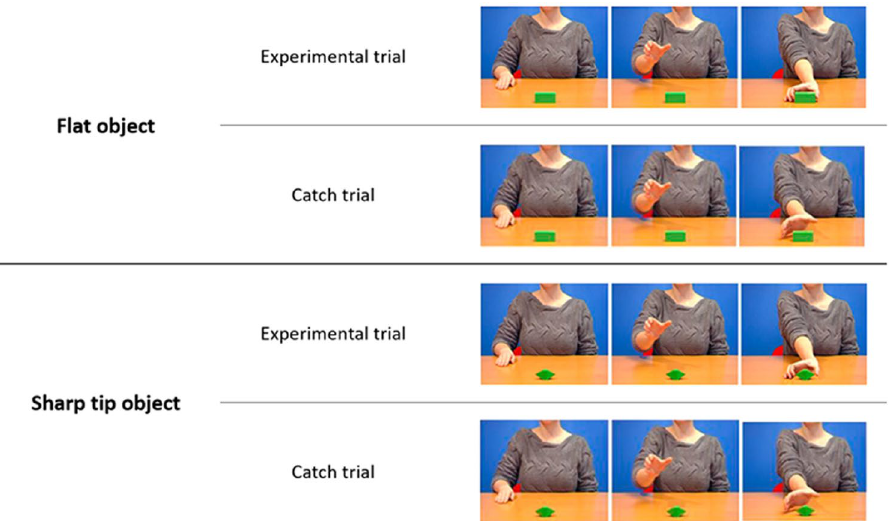
Figure 2. Three frames extracted from the flat object video (top) and the sharp-tip object video (bottom). Specifically, for each video, three frames extracted from the Experimental trial (Frame 1; Frame 25; Frame 66), and the Catch trial (Frame 1; Frame 25; Frame 38. Frame 38 was repeated 28 times to obtain the same duration as that of the experimental videos, 66 frames) are shown. The sharp-tip object videos were obtained by video editing the flat object videos. By means of a graphic software, the to-be-grasped parallelepiped was replaced by a polyhedron having the same size, but with sharp tips at the fingers opposition